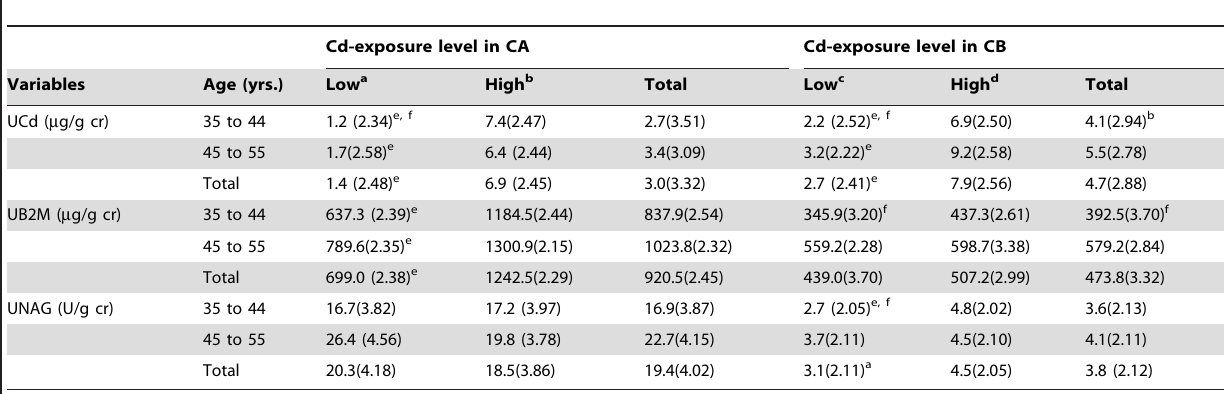
Table 2. GMs (GSDs) of levels of the three studied urinary substances of the CA and CB subjects.